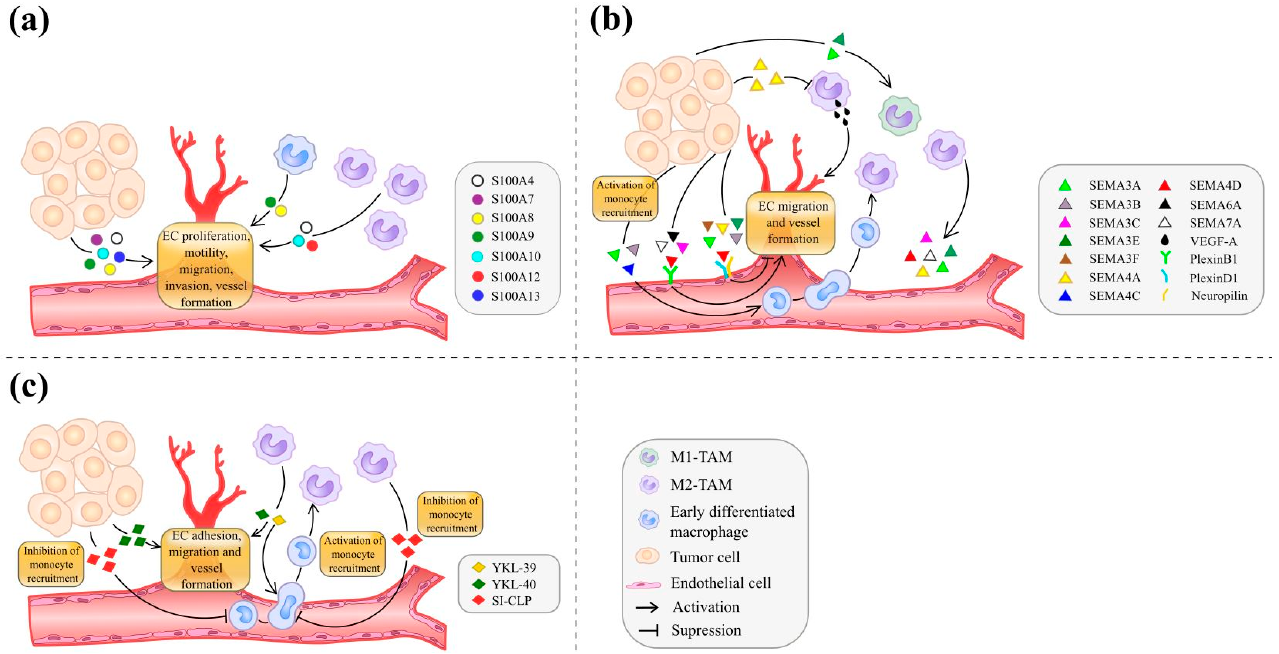
Figure 1. The role of TAM-produced soluble mediators of cell-cell interactions in tumor angiogenesis. They include the members of S100A family ( a ), of SEMA family ( b ) and of chitinase-like protein family ( c